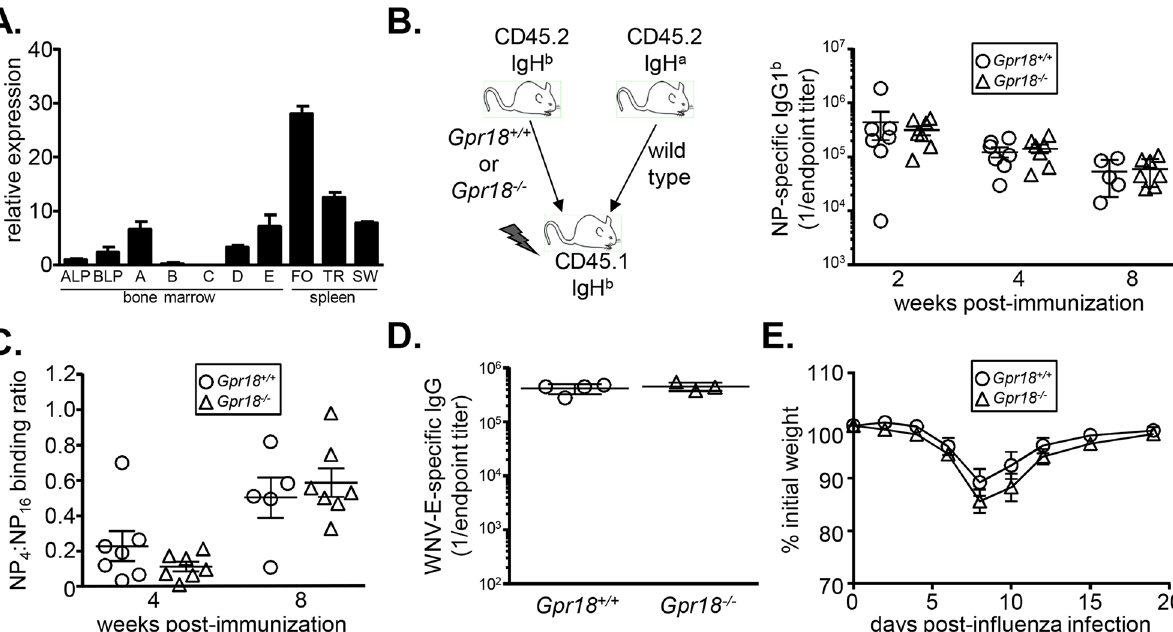
Fig 8. GPR18 is not required for antibody responses. (A) Quantitative RT-PCR analysis of GPR18 expression in B cell progenitors and mature subsets. Data are normalized to Gapdh expression. Mean values ± SEM are shown; n = 3. Data are representative of 2 independent experiments. Gating strategies are shown in S2 and S3 Figs. (B) Serum ELISA analysis of NP-specific IgG1 b antibodies at 2, 4, and 8 week post-immunization with NP-CGG. Each data point represents one chimeric animal. No significant differences were observed by Mann-Whitney non-parametric test. (C) ELISA measurements of relative affinity of NP-specific serum antibodies. Data were obtained by quantifying the ratio of high affinity (NP 4 -binding) to total (NP 16 -binding) NP-specific antibodies at 4 and 8 weeks post-NP-CGG immunization. No significant differences were observed by Mann-Whitney non-parametric test. (D) Serum ELISA analysis of WNV envelope-specific antibody titers 8 weeks post-infection. Each data point represents Gpr18 +/+ or Gpr18 -/- animal. Mean values ± SEM are shown. No significant differences were observed by Mann-Whitney non-parametric test. (E) Weight of Gpr18 +/+ and Gpr18 -/- bone marrow chimeras following infection with influenza A virus. Mean values ± SEM are shown, n = 9 mice. No significant differences using 2-tailed students' unpaired t-test were observed. ALP, all-lymphoid progenitor; BLP, B lymphoid progenitor; A-E, Hardy fractions A, B, C, D, and E; FO, follicular B cell; TR, transitional B cell; SW, isotype switched B